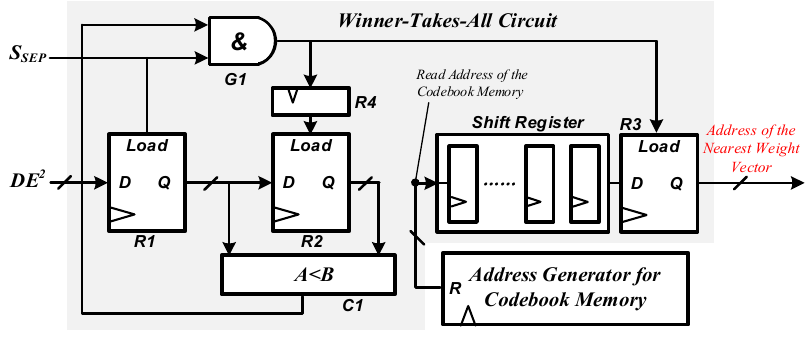
Figure 4. Block diagram of the winner-takes-all circuit.